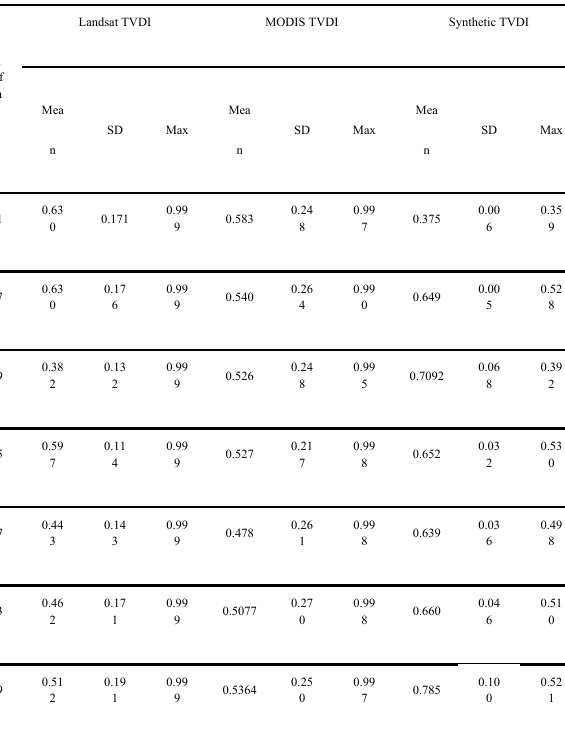
Figure 5. Scatter plot of 30m synthetic KF TVDI and Landsat inversion TVDI.